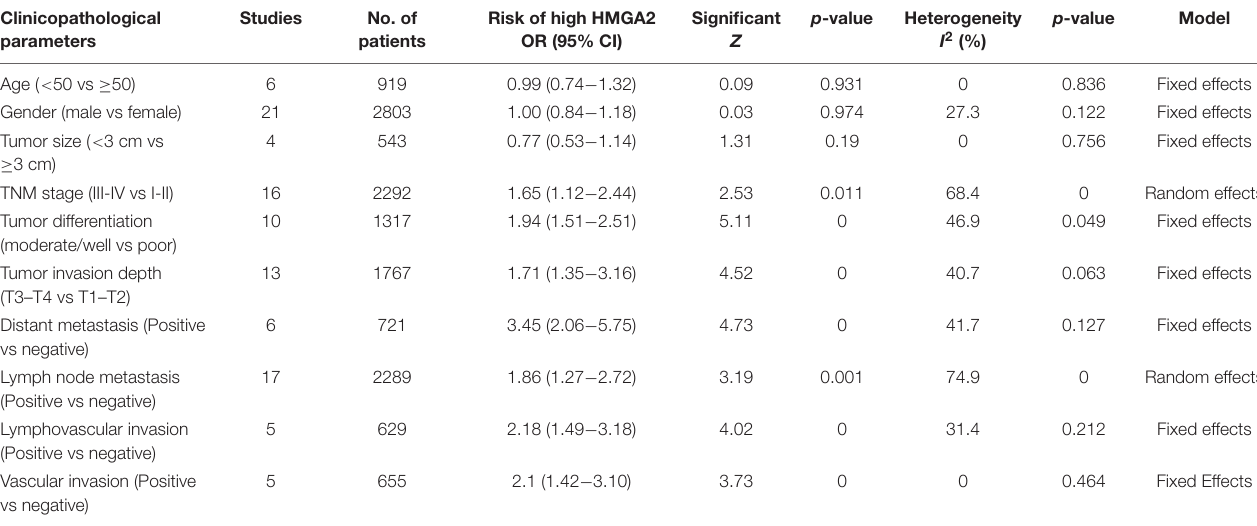
TABLE 3 | Clinicopathological features of the enrolled studies with high expressed HMGA2 in patients with cancer. Clinicopathological